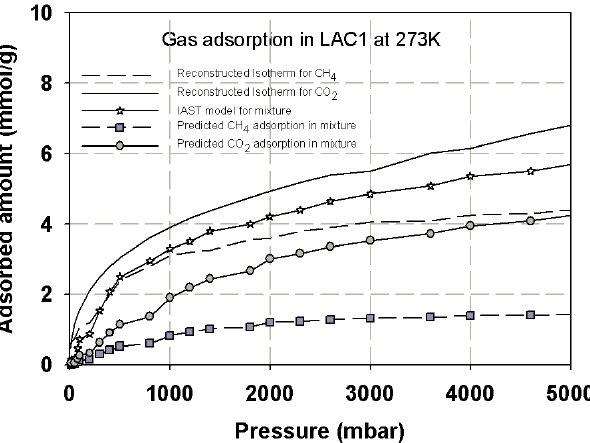
Figure 20. Simulation isotherms obtained for CH 4 and CO 2 for binary mixture of equimolar CO 2 /CH 4 in slit pore model at 273 K. Figure 12. Snapshots of CO 2 in 6.3, 9 and 20 Å pores at 273